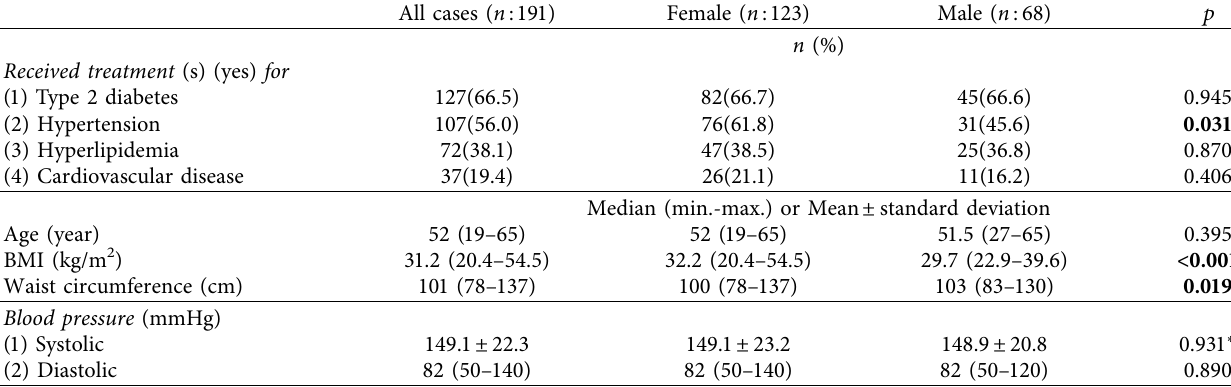
Table 1: Demographic characteristics of all cases with metabolic syndrome (MetS).